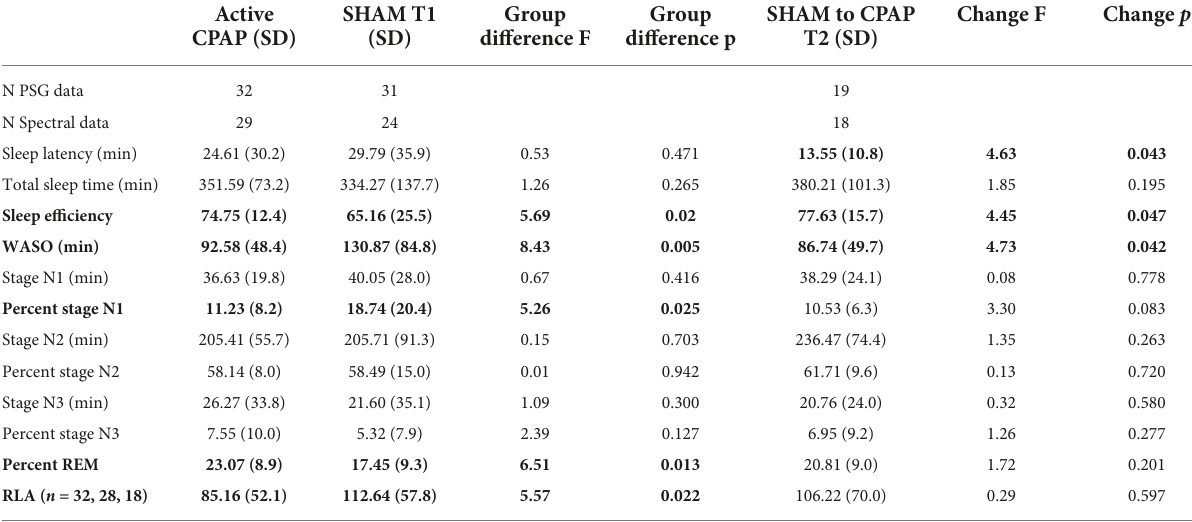
TABLE 2 PSG data for active and SHAM CPAP, and after cross-over to CPAP within the SHAM group.